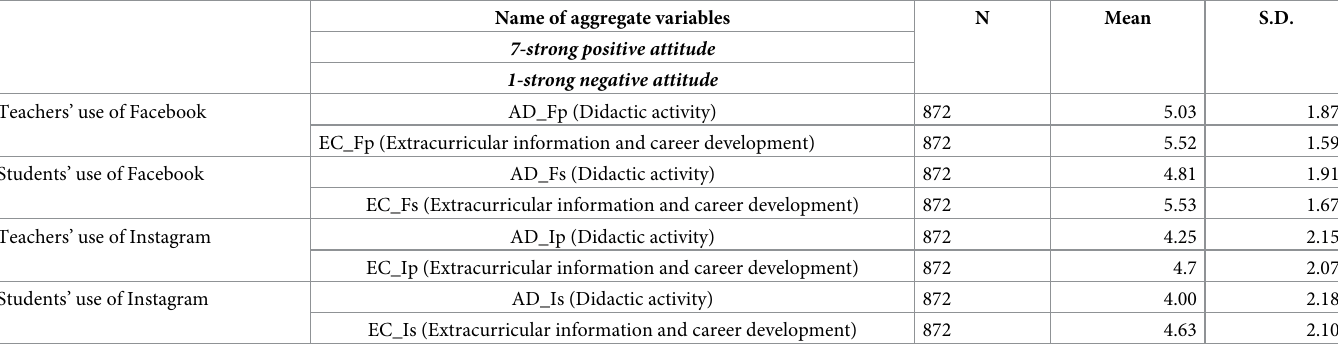
Table 2. Descriptive statistics-aggregate data.